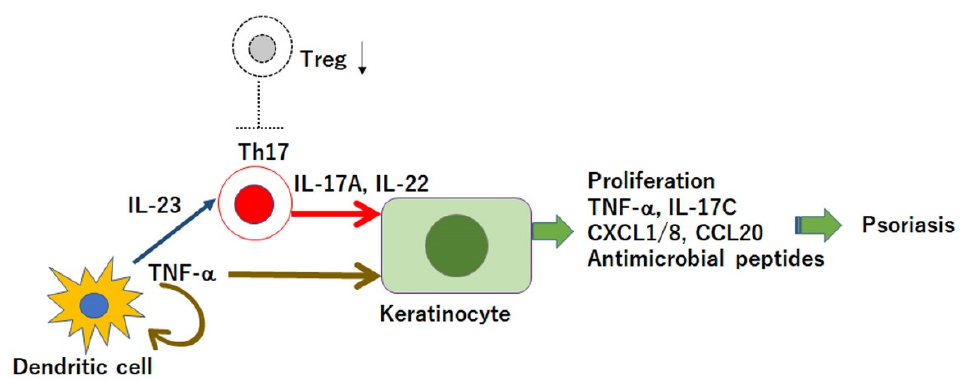
Figure 1. Tumor necrosis factor (TNF)- α /interleukin (IL)-23/IL-17 axis, and the defect in regulatory T cells (Tregs) in the pathogenesis of psoriasis. Dendritic cells secrete TNF- α that induces IL-23 secretion. IL-23 induces type 17 helper T (Th17) cells to produce IL-17A and IL-22, which act on keratinocytes and promote the proliferation and production of cytokines, antimicrobial peptides, or chemokines; thus, inducing inflammation. In psoriasis, Tregs are dysfunctional and cannot sufficiently suppress the activity of Th17 cells.